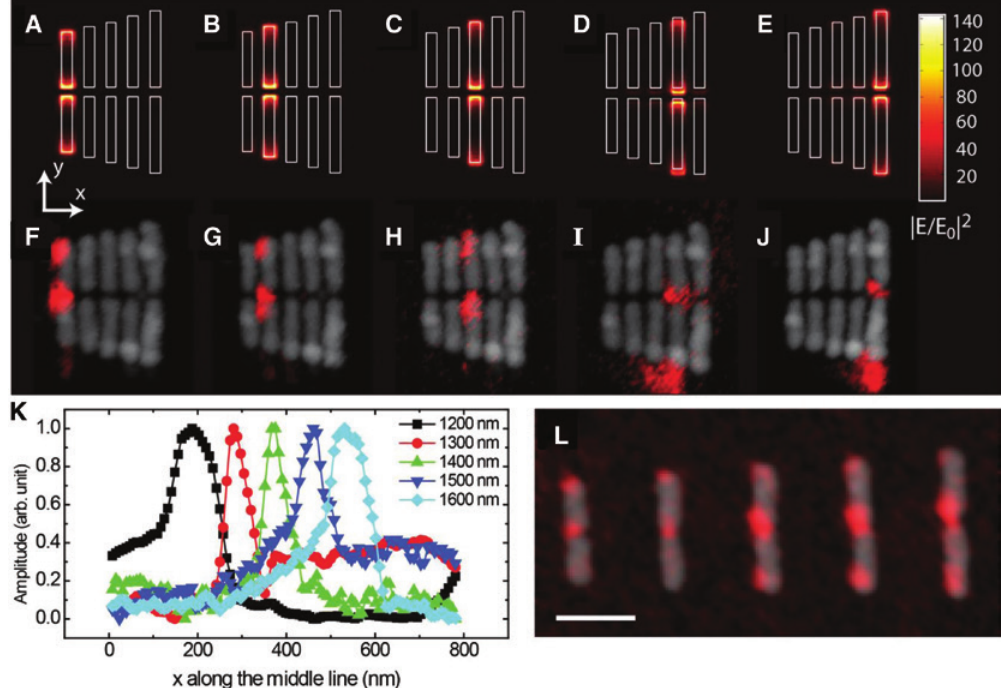
Figure 2: Experimental verification of the selective excitation of individual antennas in the plasmonic antenna array. (A–E) Simulated near-field distributions of the antenna array at five different wavelengths: 1200 nm (250 THz), 1300 nm (230.8 THz), 1400 nm (214.3 THz), 1500 nm (200 THz), and 1600 nm (187.5 THz). (F–J) Corresponding experimental observations show very good agreement with the simulations. (K) Measured intensity of light integrated along the y -direction, versus the x -direction, at each measured wavelength. (L) Near- field measurement at 1400 nm wavelength on the control sample, which consists of an array of antennas with the same geometry specifica- tion but at a large nearest neighbor separation of 300 nm. Reprinted from Ref. [25]. Copyright © 2012 by the American Physical